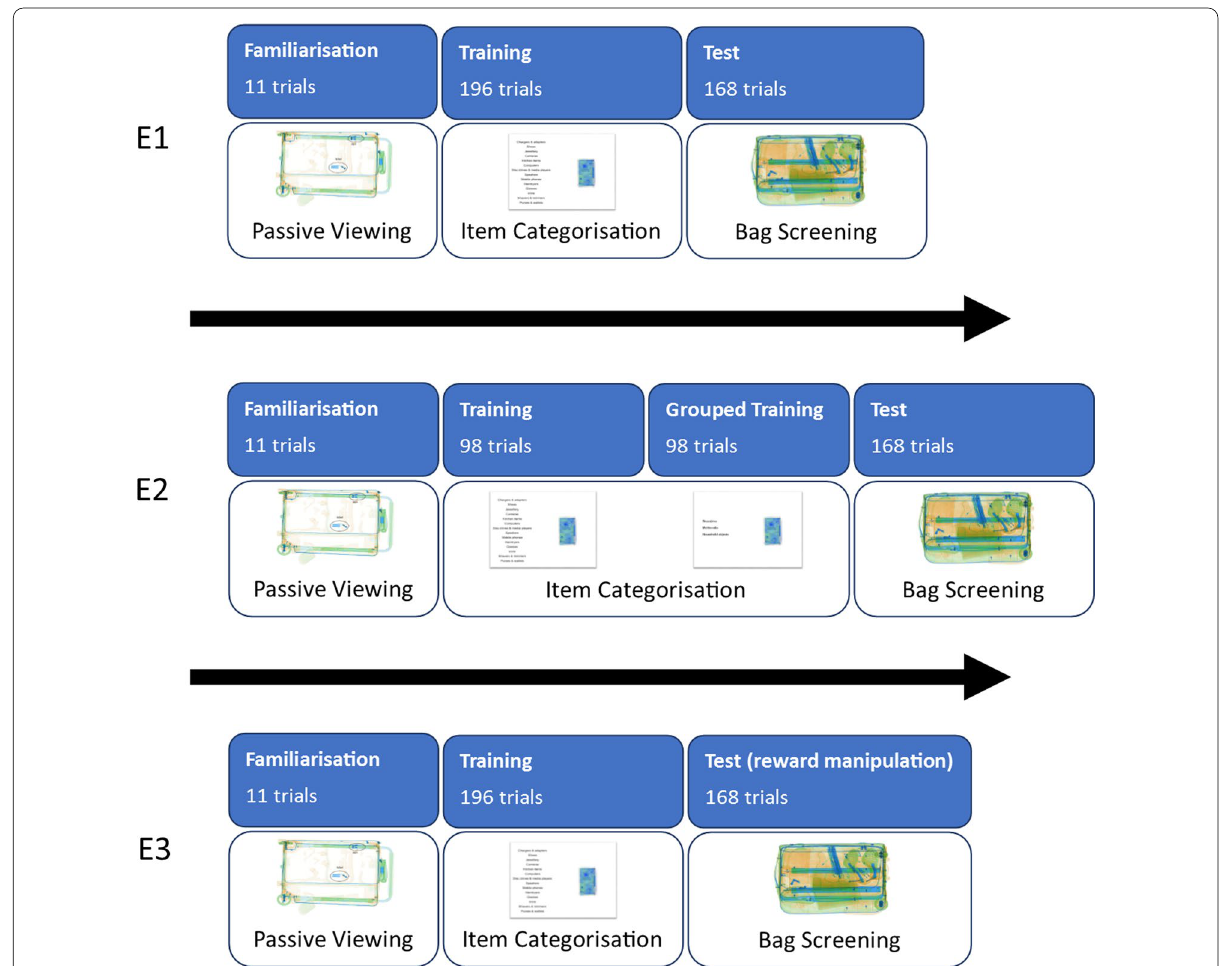
Fig. 1 Outline Procedures for Experiments 1 to 3 (see Fig. 2 for a more detailed example of an item categorisation